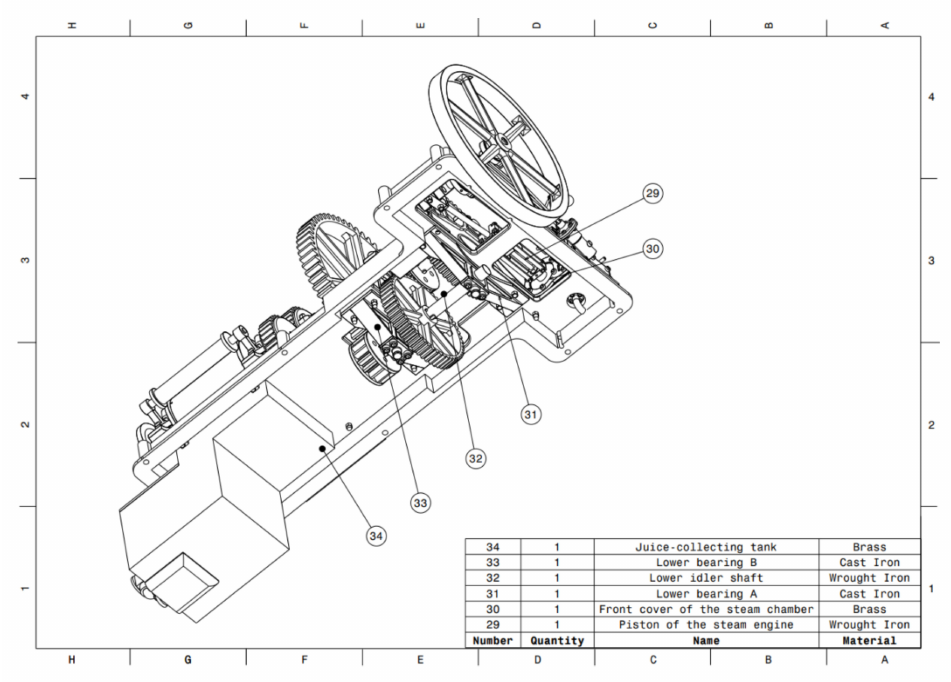
Figure 4. Assembly plan from bottom view (Elements